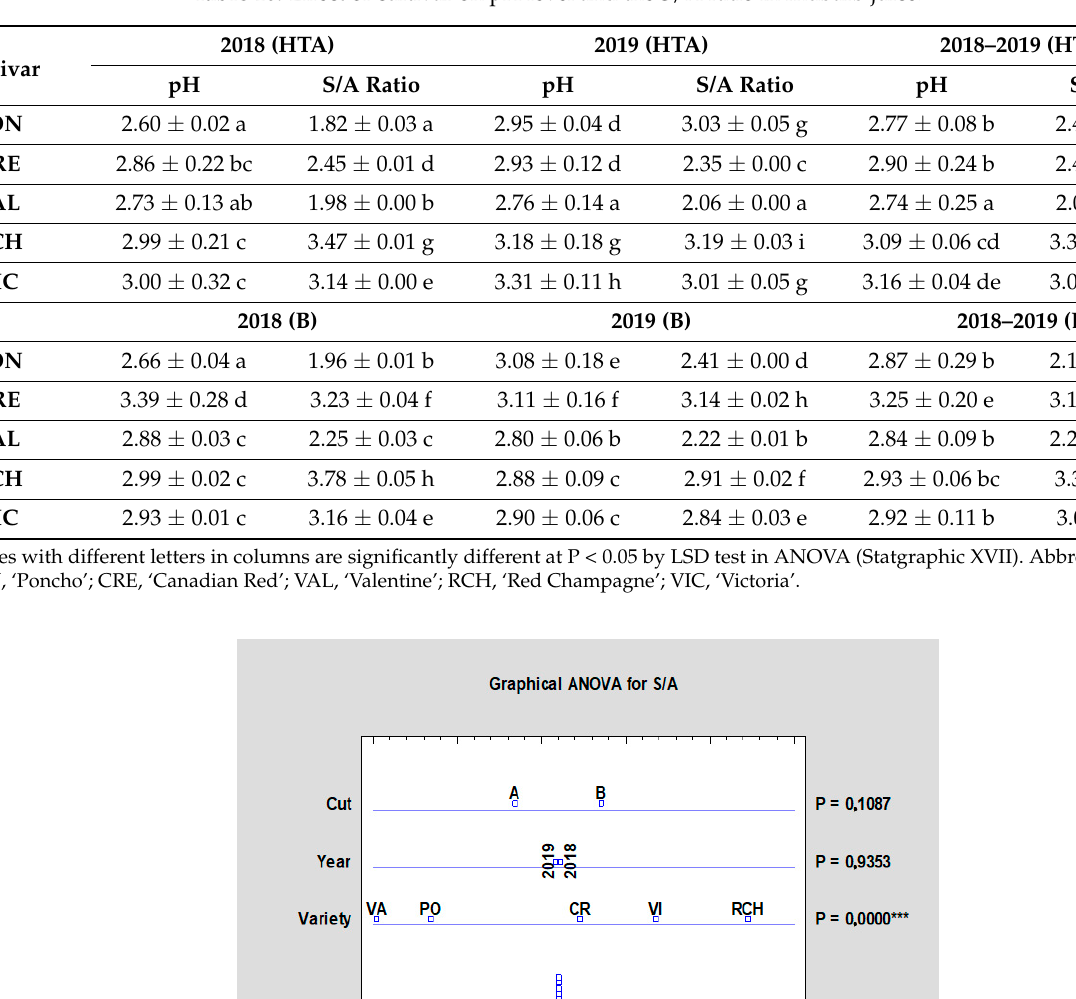
Table 10. Effect of cultivar on pH level and the S/A ratio in rhubarb juice. Cultivar